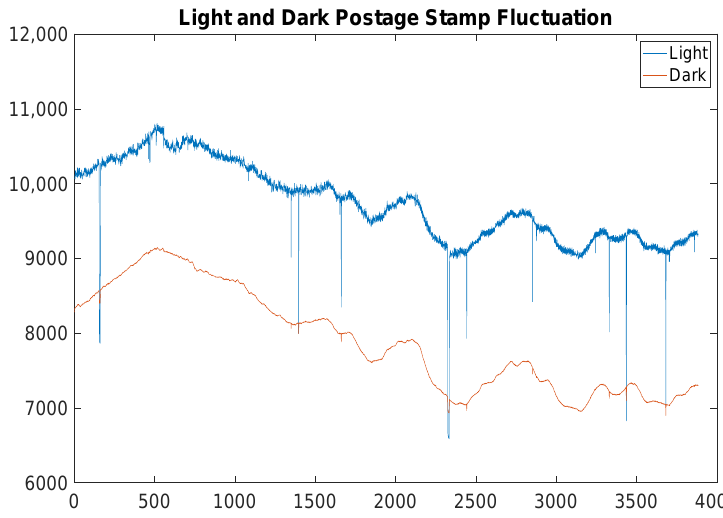
Figure 2. The above graph shows real light and dark postage stamp fluctuation over the time scale of a scan of the middle portion of the simulated munition. The light postage stamp has higher counts throughout, except when the beam drops out entirely. Note the long-term fluctuation is on the order of